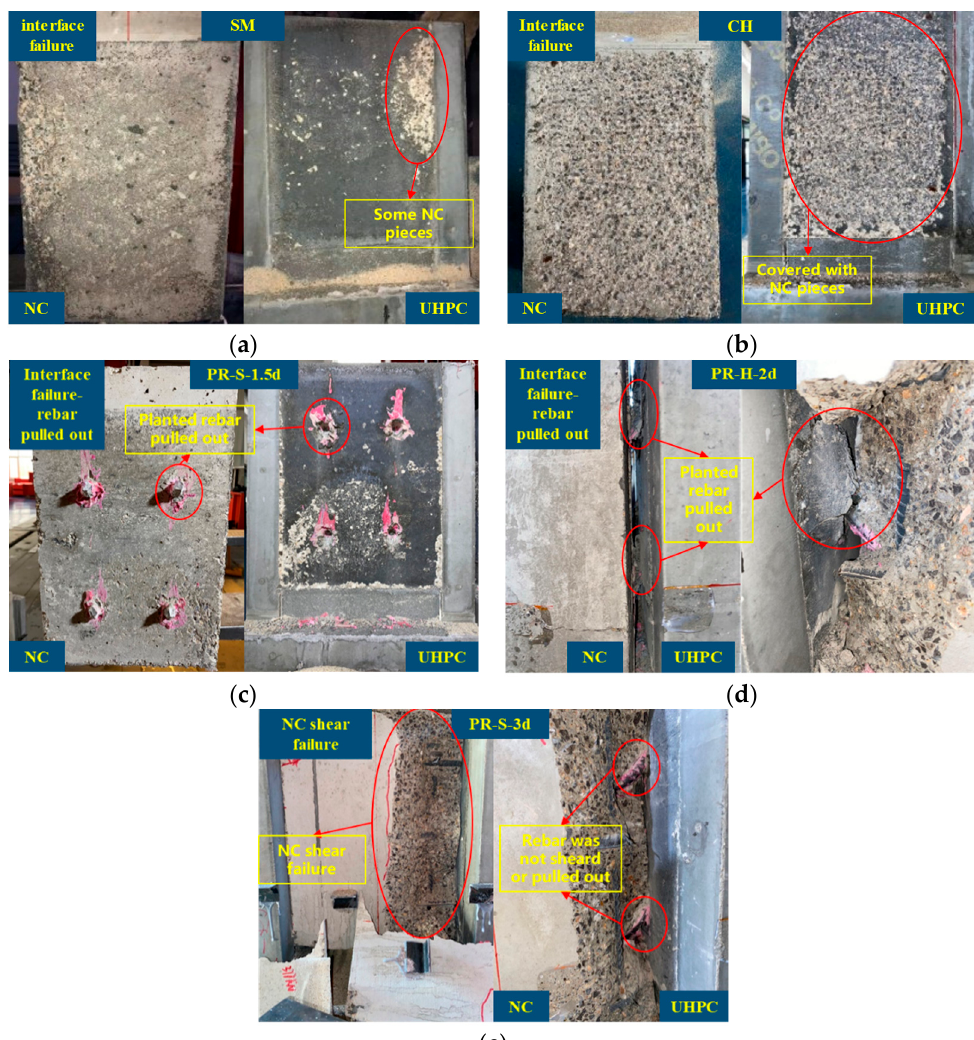
Figure 4. Failure models of UHPC–NC push-out specimens . ( a ) SM-3; ( b ) CH-2; ( c ) PR-S-1.5d-1; ( d ) PR-H-2d-2; ( e ) PR-S-3d-3.